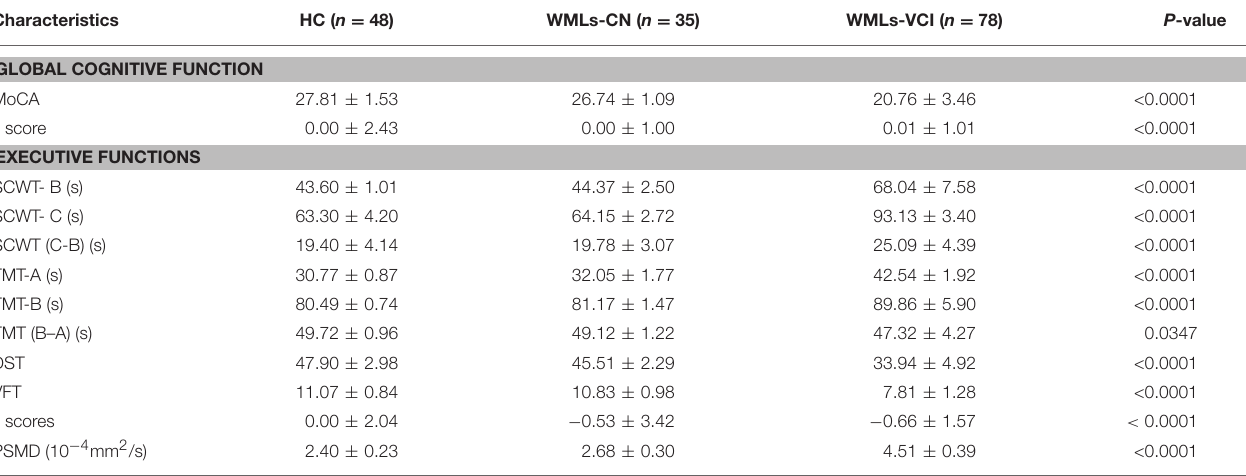
TABLE 2 | Cognitive function measures and the peak width of skeletonized mean diffusivity in the study population.